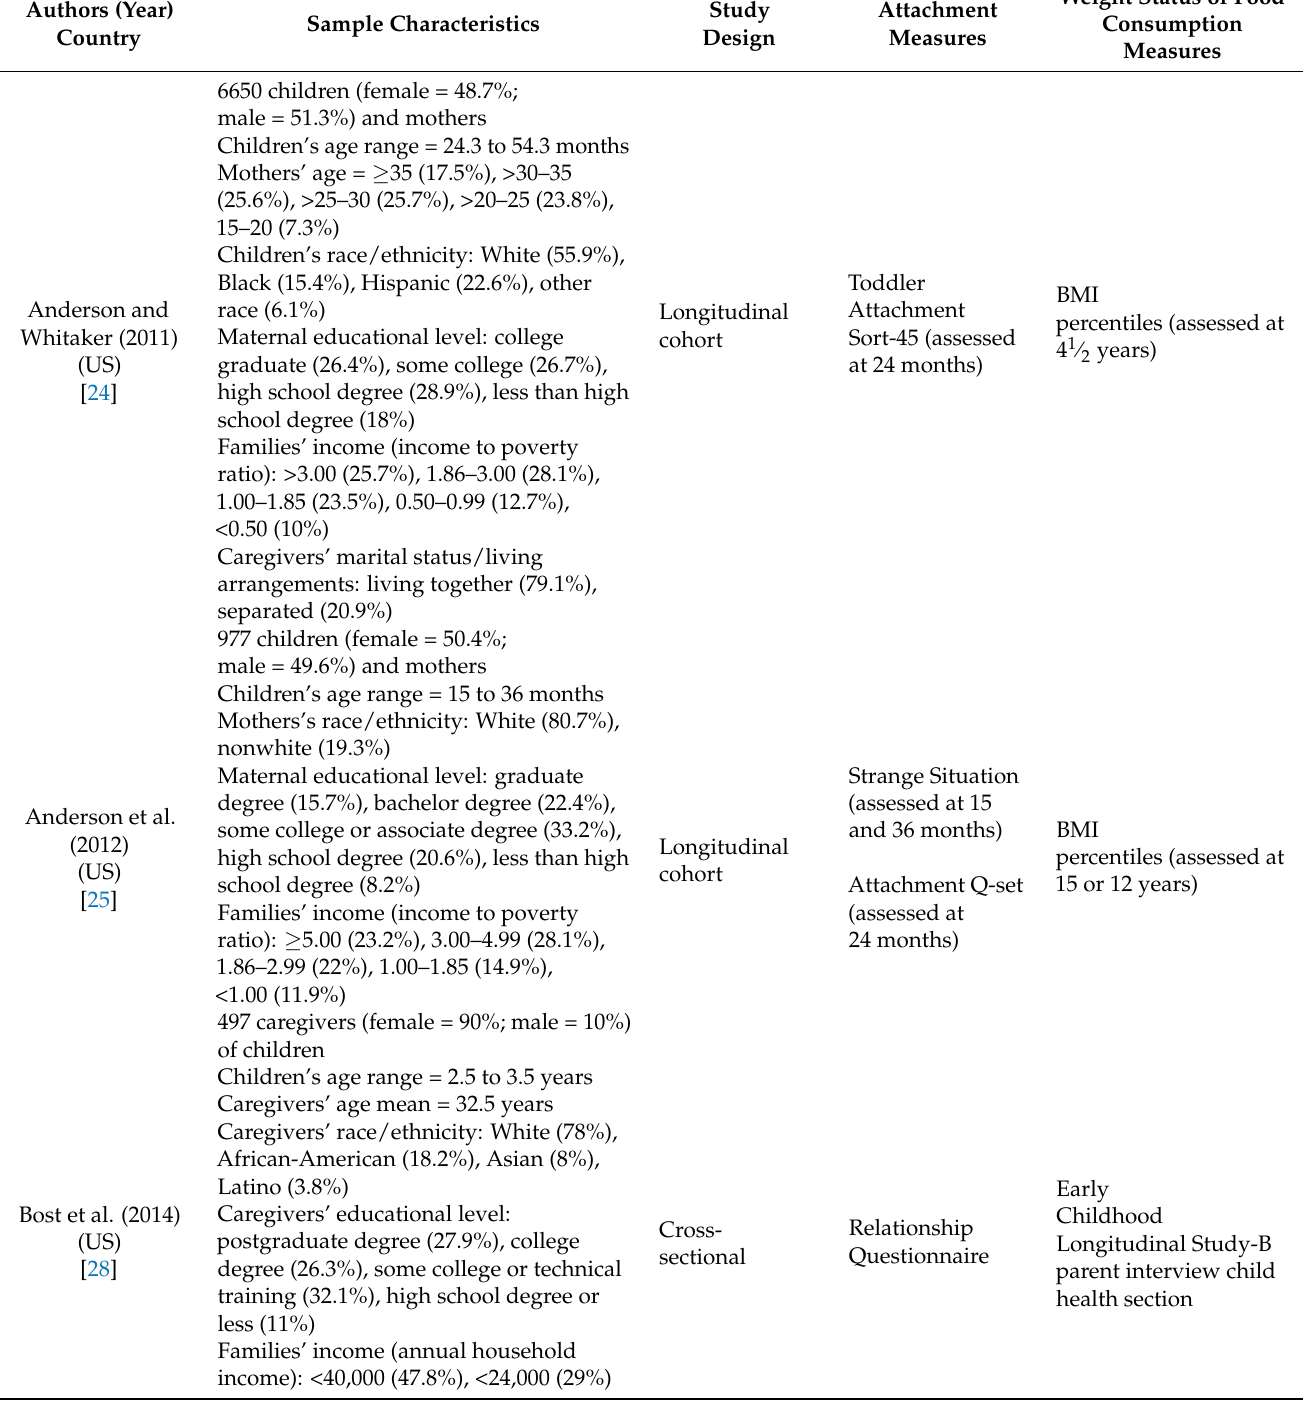
Table 1. Summary of studies examining attachment quality and children’s weight status or food consumption. Authors (Year) Sample Country